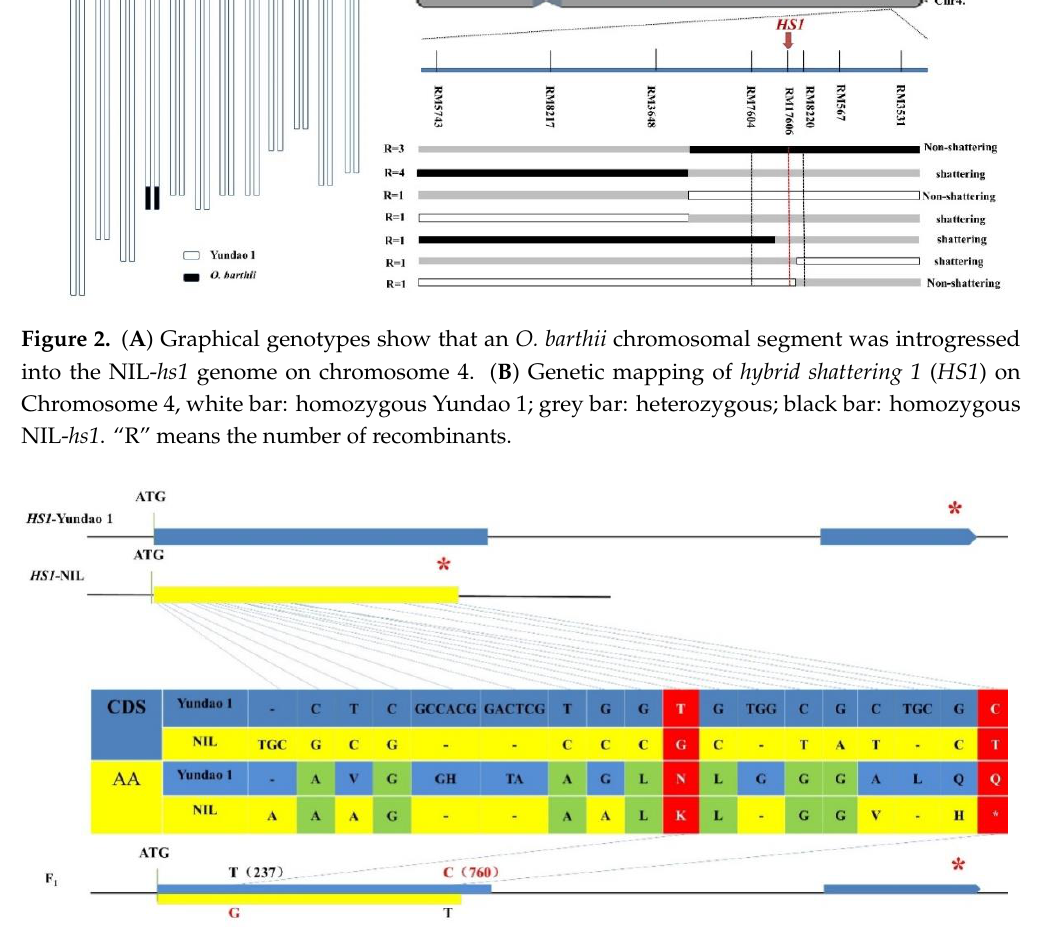
Figure 3. The difference in the coding sequence and amino acid of HS1 between Yundao 1 and NIL- hs1 . Synonymous mutations and functional mutations were shown in green and red, respectively. The asterisk indicates the stop codon.